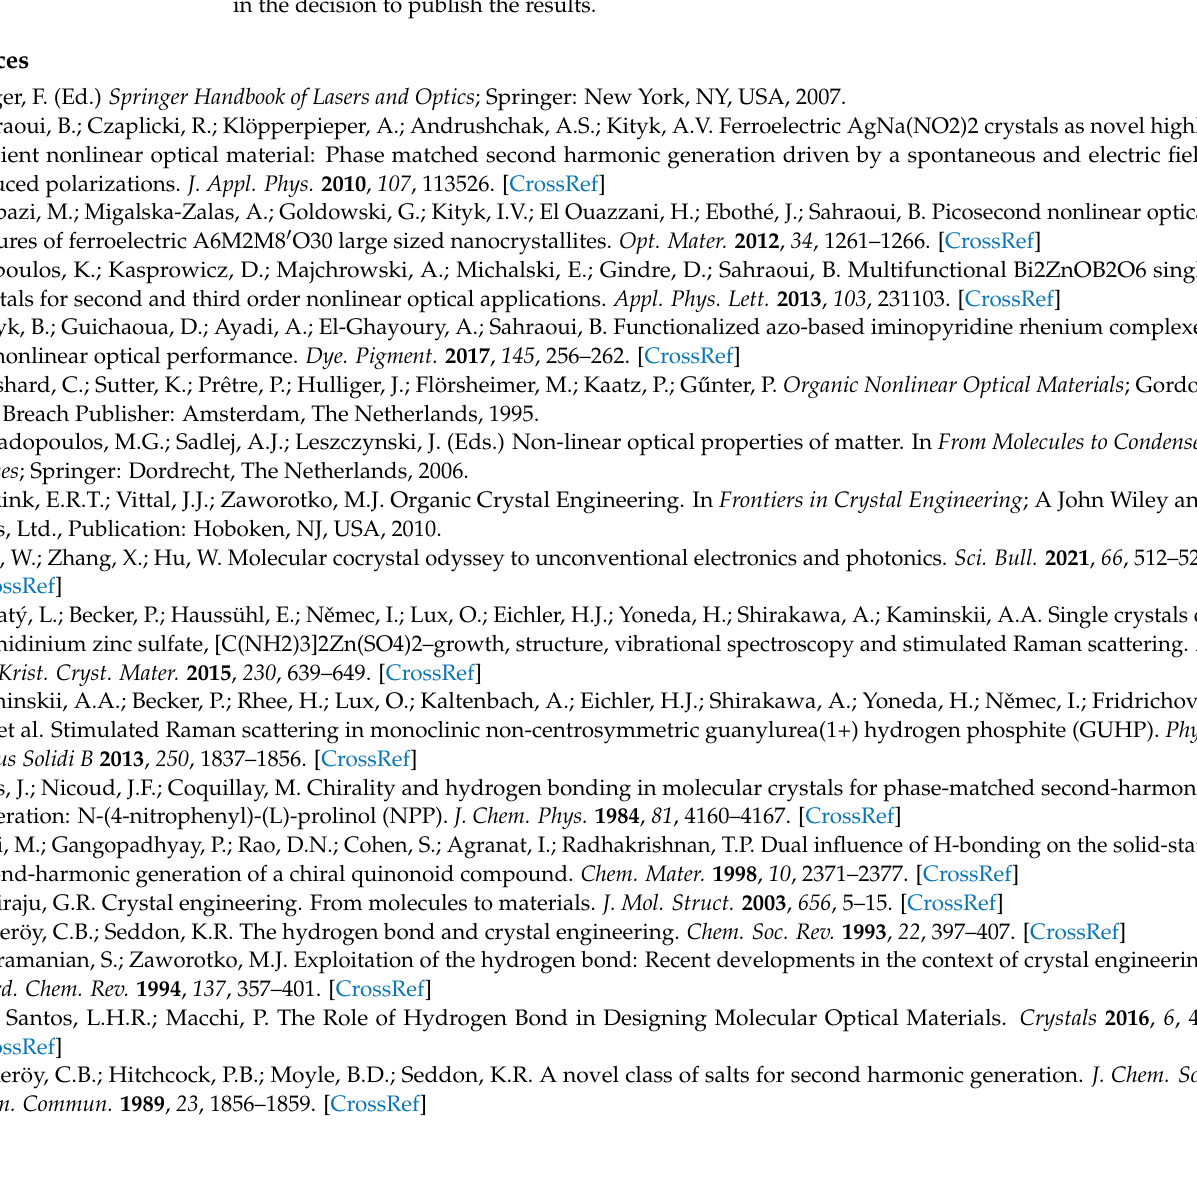
Table S16: Experimental powder diffraction data for phbigua 2 HPO 3 2H 2